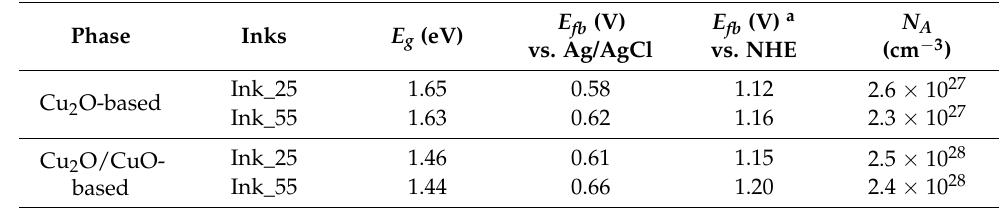
Figure 8. UV–Vis diffuse reflectance spectra of films produced with Cu 2 O-based ink ( a ) and Cu 2 O/CuO-based ink ( b ), and related Tauc plots for Cu 2 O-based ink ( c ) and Cu 2 O/CuO-based ink ( d ). Table 3. Bandgap values calculated from Figure 8, flat-band potential ( E fb ) and number of donors ( N A ) for the prepared photoelectrodes.